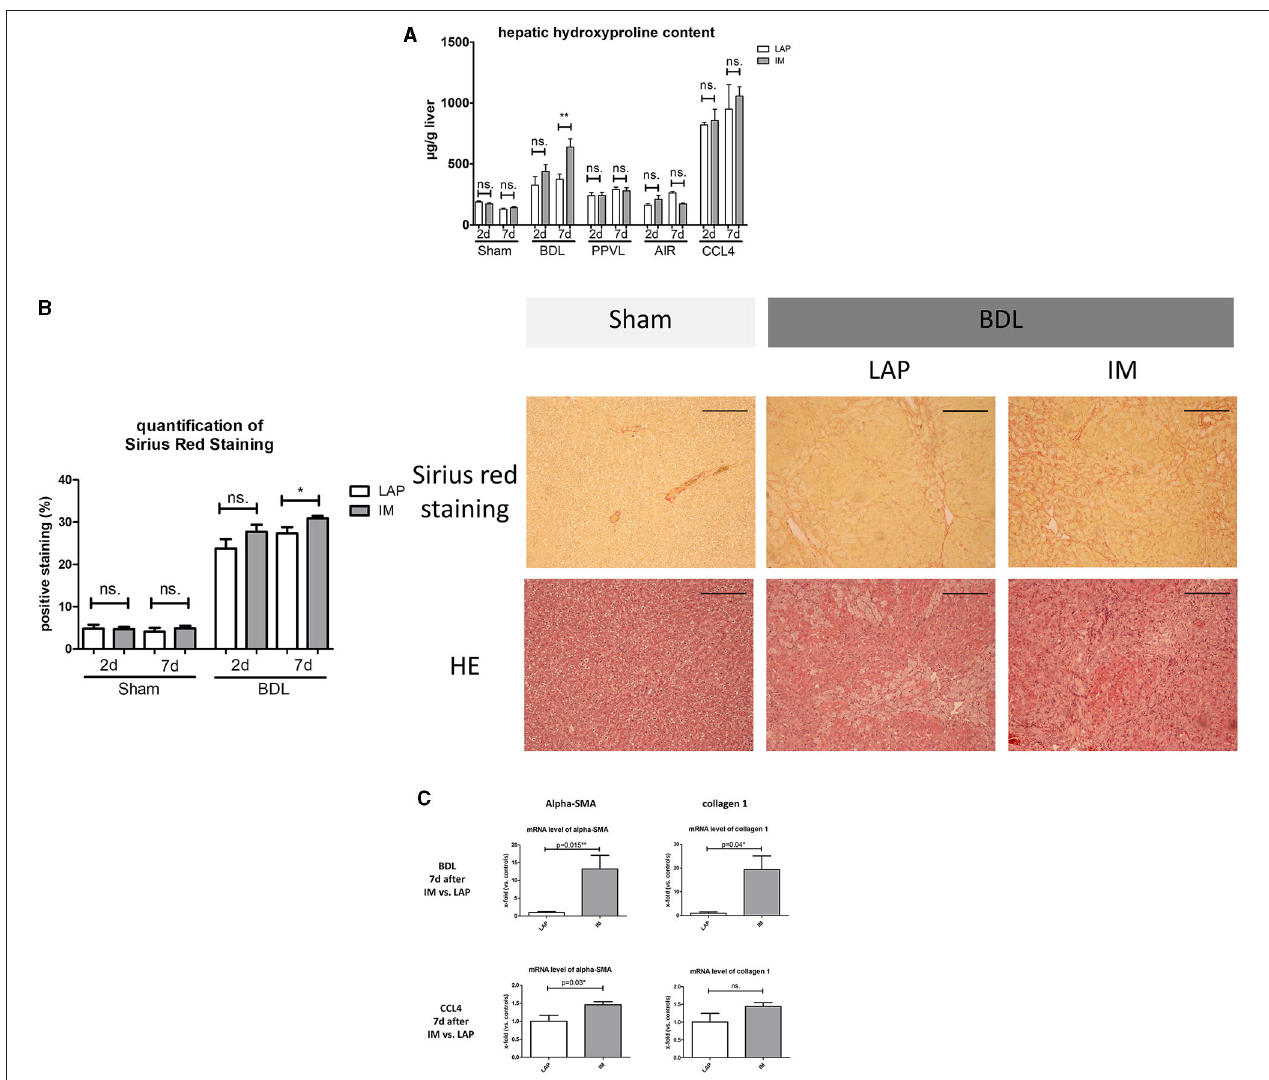
FIGURE 2 | (A) Hepatic hydroxyproline content measurements 2 or 7 days after IM vs. LAP, showing progression of fibrosis through a highly significant elevation of hydroxyproline concentration (expressed in µ g/g liver) of the liver in the BDL group 7 days after IM vs. LAP. No differences are seen within the Sham, PPVL, and CCL4 groups. (B) Representative images of liver samples with Sirius-red staining for assessment of fibrosis with observed significant differences of fibrosis (expressed as percentage of positive stained area) 7 days after intestinal manipulation vs. the respective control group (LAP). Images of Hematoxylin Eosin staining are shown for morphologic comparison. The scale bar is 200 µ m. (C) mRNA gene expression for alpha-SMA and collagen 1, showing a significant increase of both parameters of fibrosis progression in the BDL group 7 days after IM and for alpha-SMA in the CCL4 group 7 days after IM. Levels of gene expression are shown as x-fold compared to the respective control group. * p ≤ 0.05; ** p ≤ 0.01; ns. (p > 0.05).